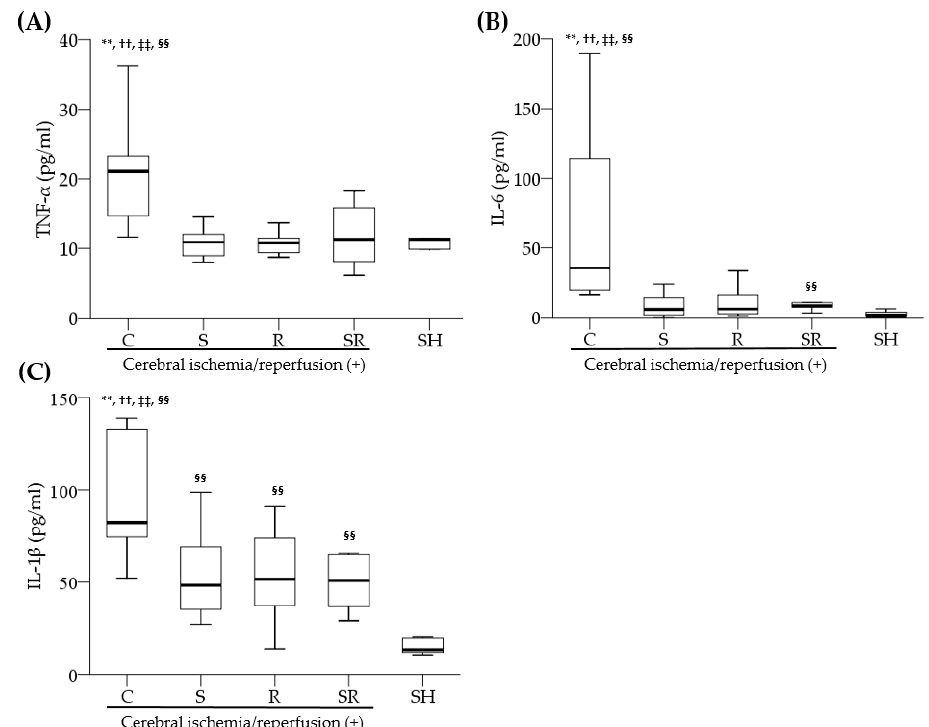
Figure 4. Serum levels of ( A ) tumor necrosis factor-alpha (TNF- α ), ( B ) interleukin-6 (IL-6), and ( C ) interleukin1 beta (IL-1 β ) measured 24 h following transient global cerebral ischemia and assayed by ELISA. ** p < 0.01 for Group S; †† p < 0.01 for Group R; ‡‡ p < 0.01 for Group SR; §§ p < 0.01 for Group SH.